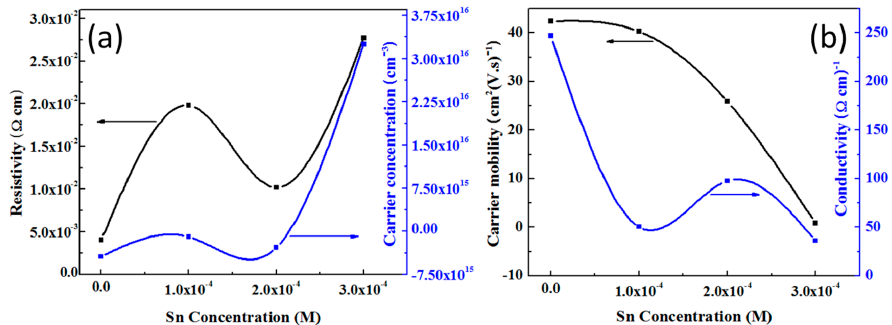
Figure 11. ( a ) Resistivity and carrier concentration and ( b ) carrier mobility and conductivity as a function of Sn concentration.